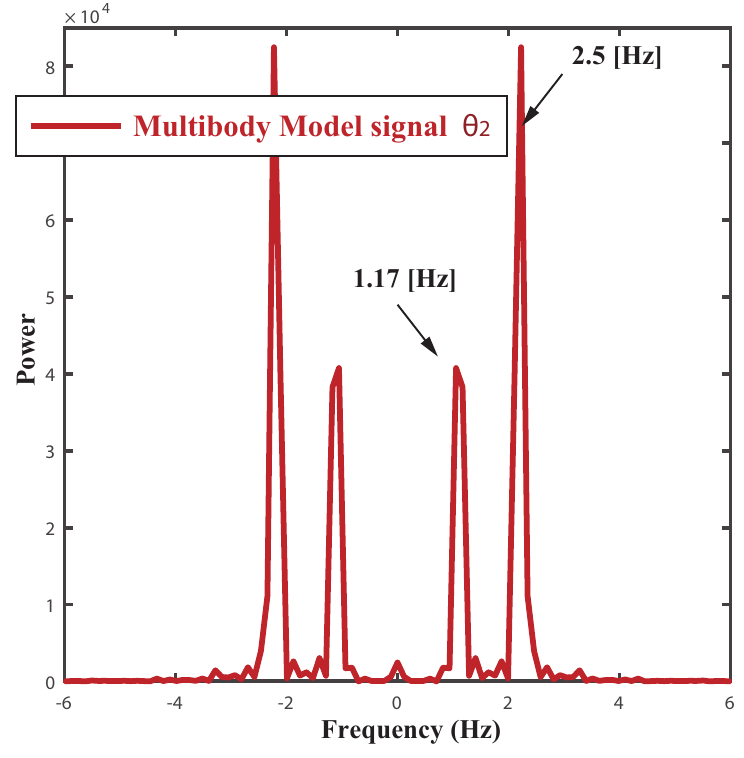
Figure 10. Fast Fourier Transform (FFT) of the simulated dynamic signal θ 2 ( t ) . Conditions: Multibody model, sampling frequency 60